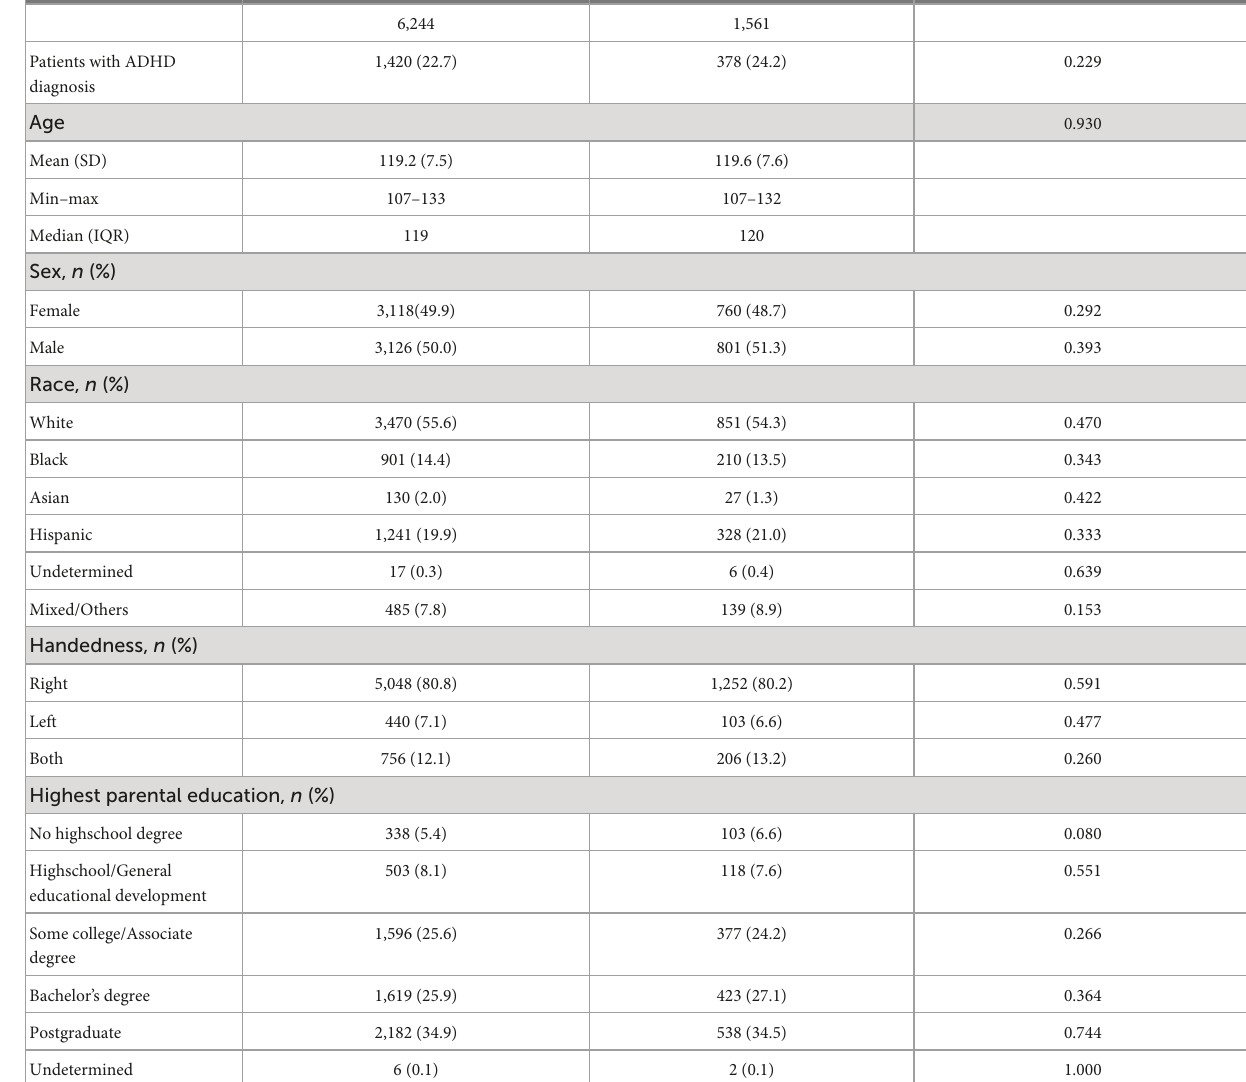
TABLE 2 Demographic characteristics of train/Cross-validation versus independent test cohorts. Patients’ characteristic in training/Cross-validation cohort and independent validation cohort Training/Cross-validation cohort Independent validation cohort p- valuetraining vs.